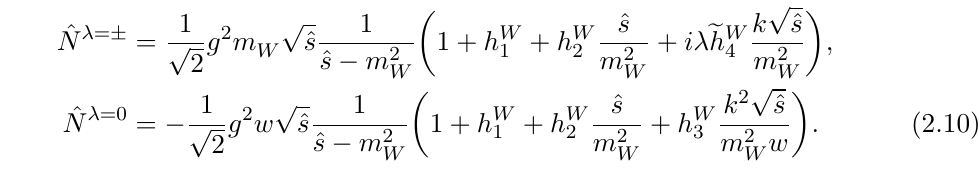
Figure 4 . It is shown how the states in the process q (cid:22) q u (cid:22) d W + H (lower) transform under C , P and T without interchanging the initial and (cid:12)nal states ! (denoted by e T